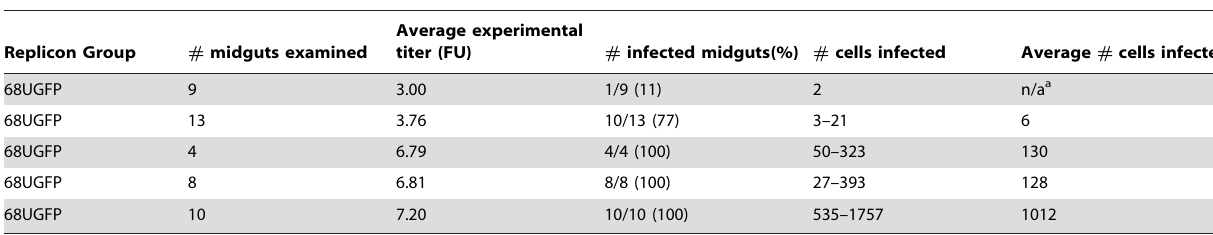
Table 4. Initial midgut infection of 68U201 replicons in C. taeniopus .